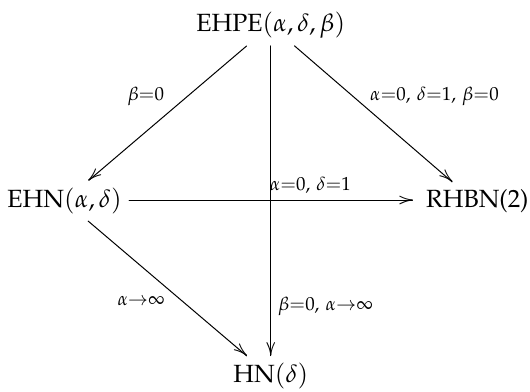
Figure 1. Particular cases for the EHPE